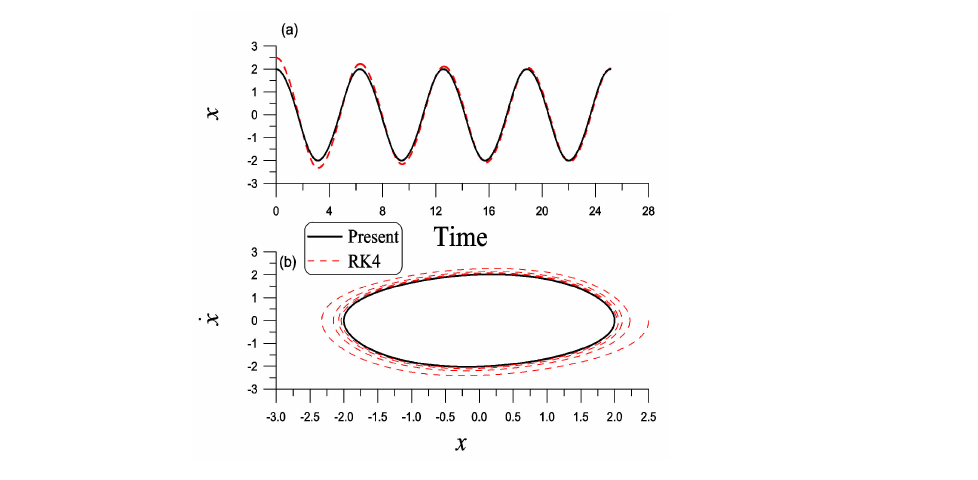
. (cid:0) (cid:1) x , x .